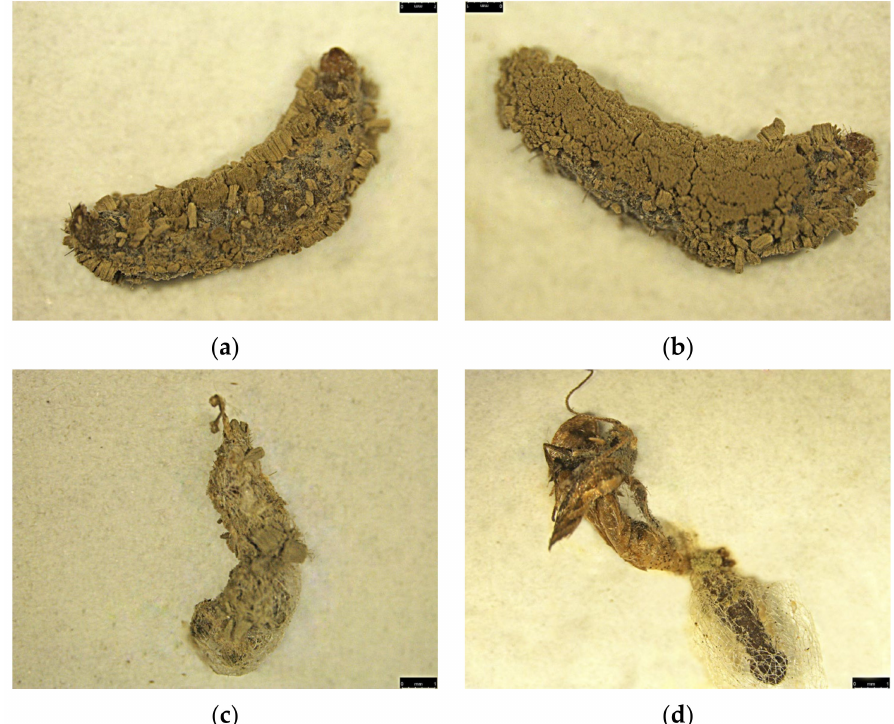
Figure 10. Fungal growth on various stages of P. xylostella infected with M. anisopliae . ( a ) Fungal growth over ventral region of larval body; ( b ) fungal growth over dorsal surface of larval stage; ( c ) fungal growth during pupal stage; ( d ) fungal infection resulting in failed adult